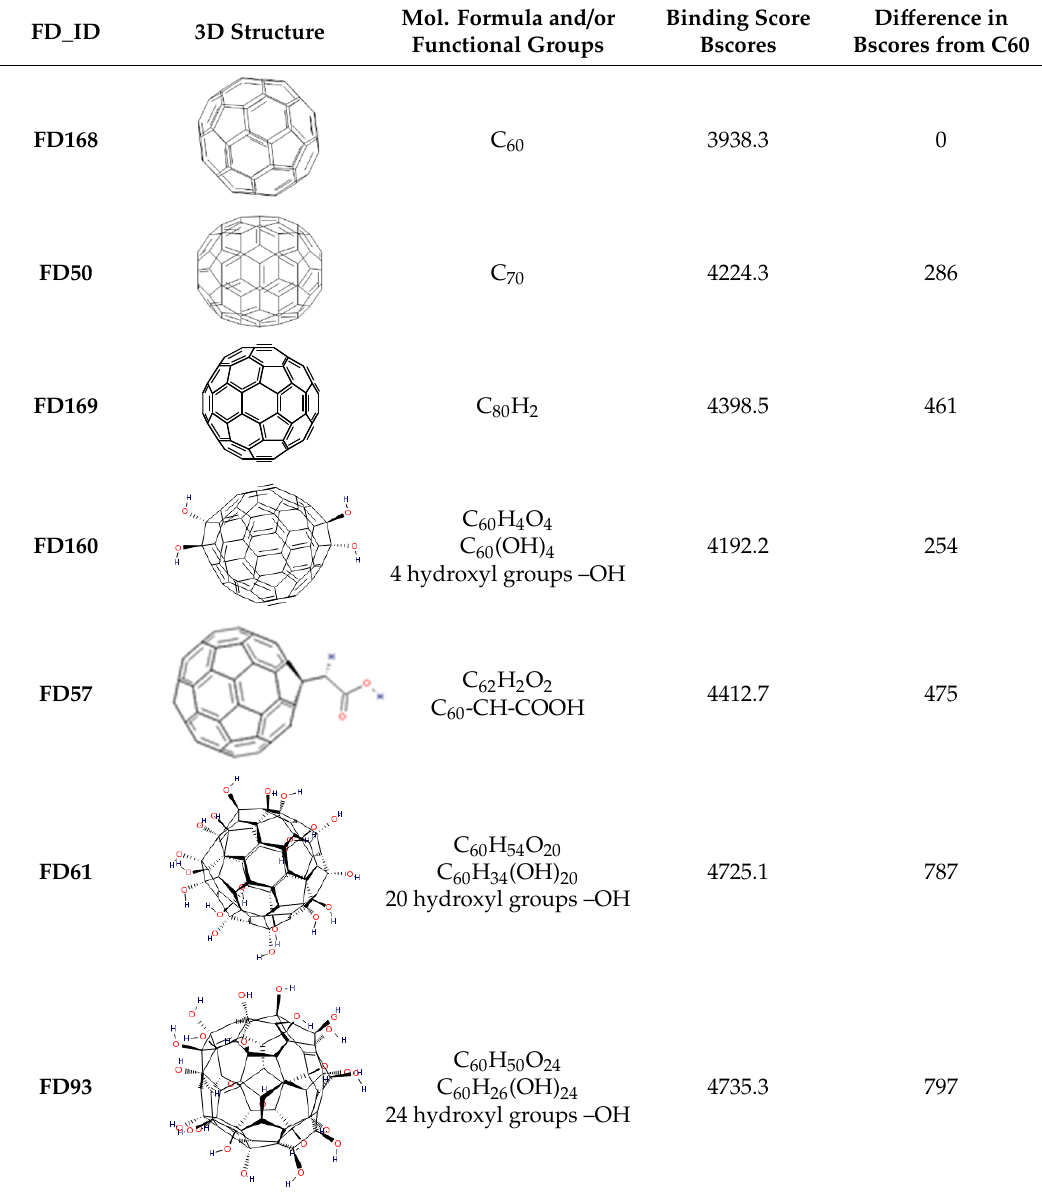
Table 3. The summary table for the least active fullerenes and fullerene derivatives without functional groups or with a minimal number of them.